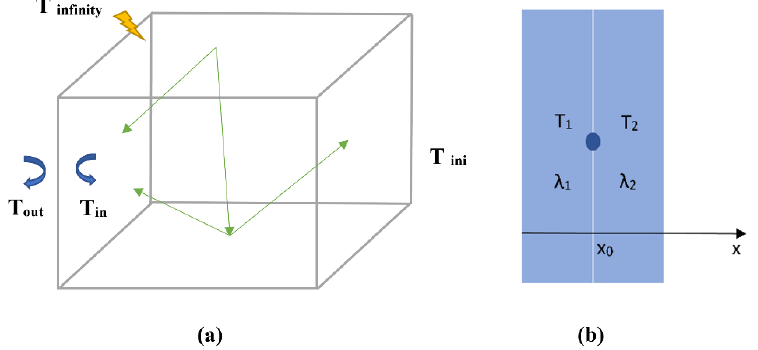
Figure 6. Illustration of thermal phenomena and boundary/interface conditions: ( a ) boundary con- ditions; ( b ) Interface conditions.